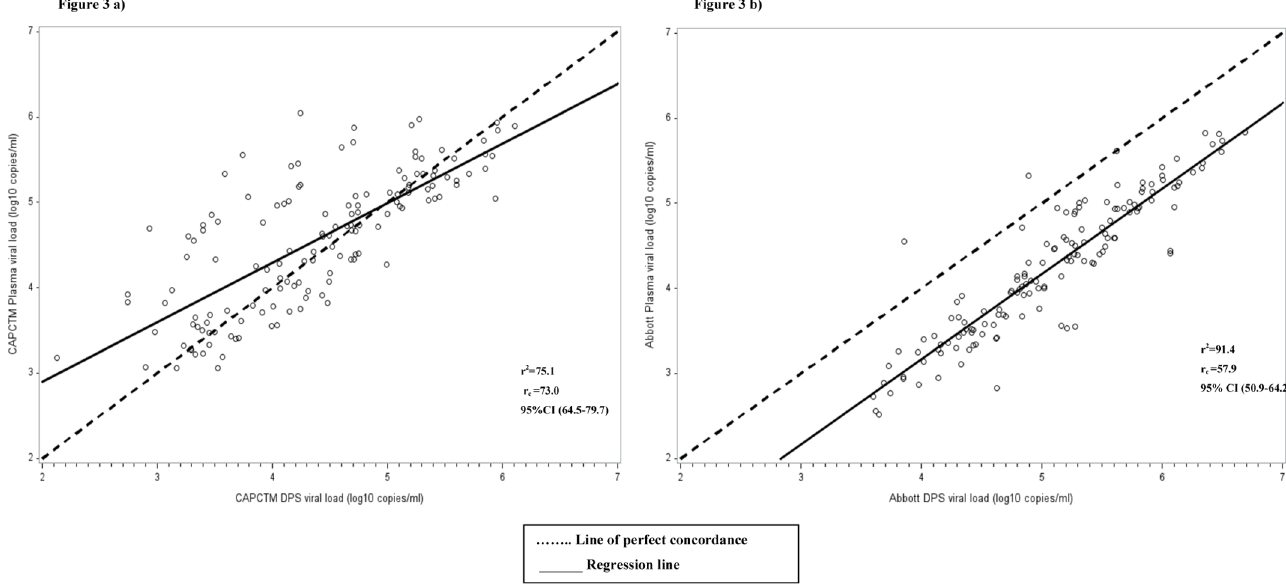
Fig 3. Concordance correlation analysesof HIV-1 viral load (VL) quantification among plasma and dried plasma spot specimens collected from patients visiting Nyanza patient support centers and tested with CAP/CTM and Abbott. a) CAP/CTM plasma vs. DPS VL; b ) Abbott plasma vs. DPS